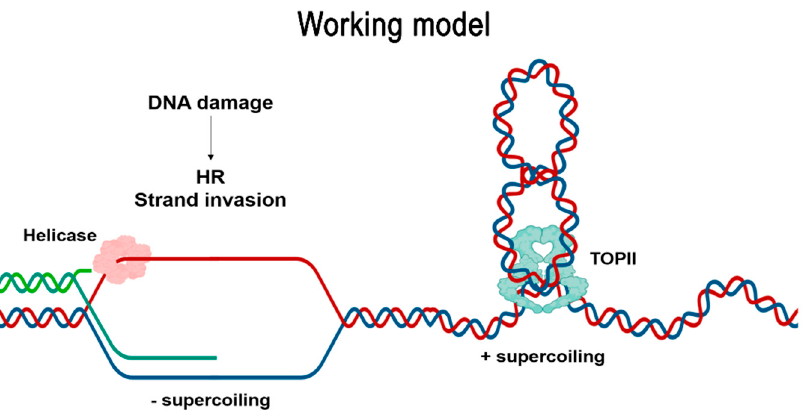
Figure 6. Working model of TOPII participation in the resolution of topological stress generated during HR. When DNA damage is repaired by homologous recombination, the DNA double-helix of the repair template needs to be uncoiled by the action of helicases to form a D-loop, thereby enabling strand invasion. This generates negative supercoiling of the DNA, which in turn is compensated by positive supercoiling at both ends of the D-loop. TOPII potentially relieves part of the mechanical stress generated in the vicinity of the HR intermediate, facilitating the repair